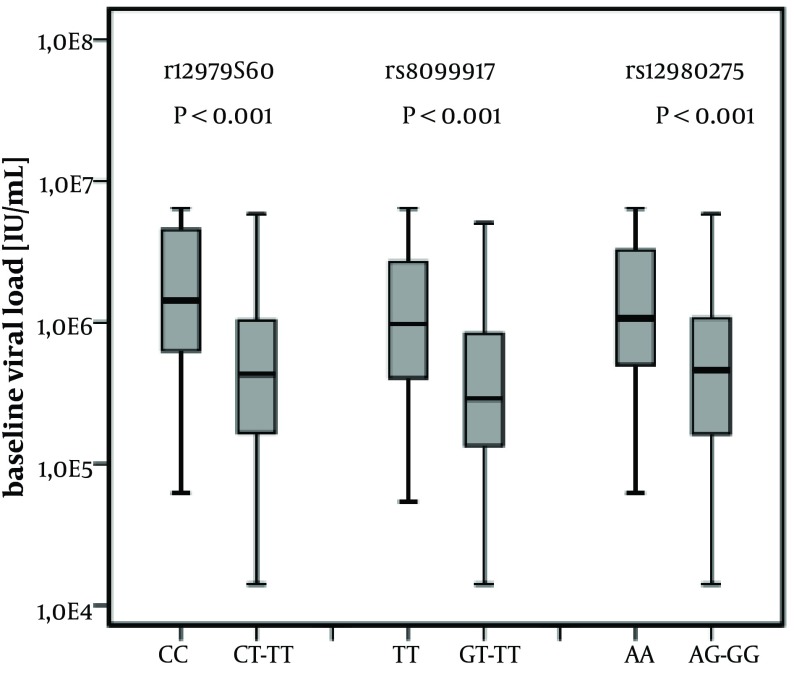
The Association of IL-28B SNP With Baseline Viral Load in Chronic HCV PatientsThere were significant differences in viral load between patients carrying CC and CT-TT rs12979860, TT and TG-GG rs8099917 and AA and AG-GG rs12980275 genotypes. Data are median with 10th, 25th, 75th and 90th percentiles as vertical boxes with error bars.